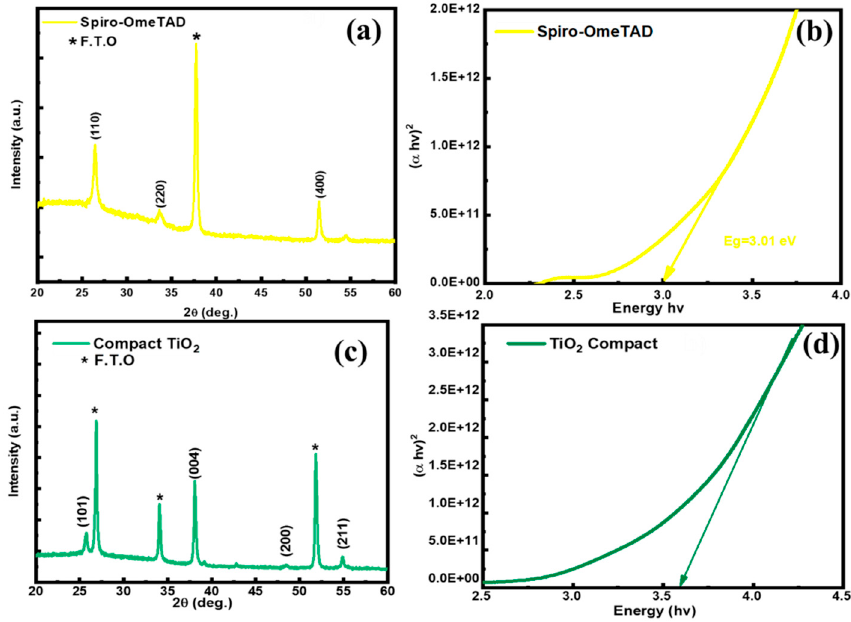
Figure 8. ( a ) XRD Pattern of the Spiro-OmeTAD film, ( b ) bandgap spectra of the Spiro-OmeTAD film, ( c ) XRD pattern of the TiO 2 compact layer, ( d ) bandgap spectra of the TiO 2 compact layer. “3.5E+12” represents “3.5 × 10 12 ”, same applies to other E notations in the